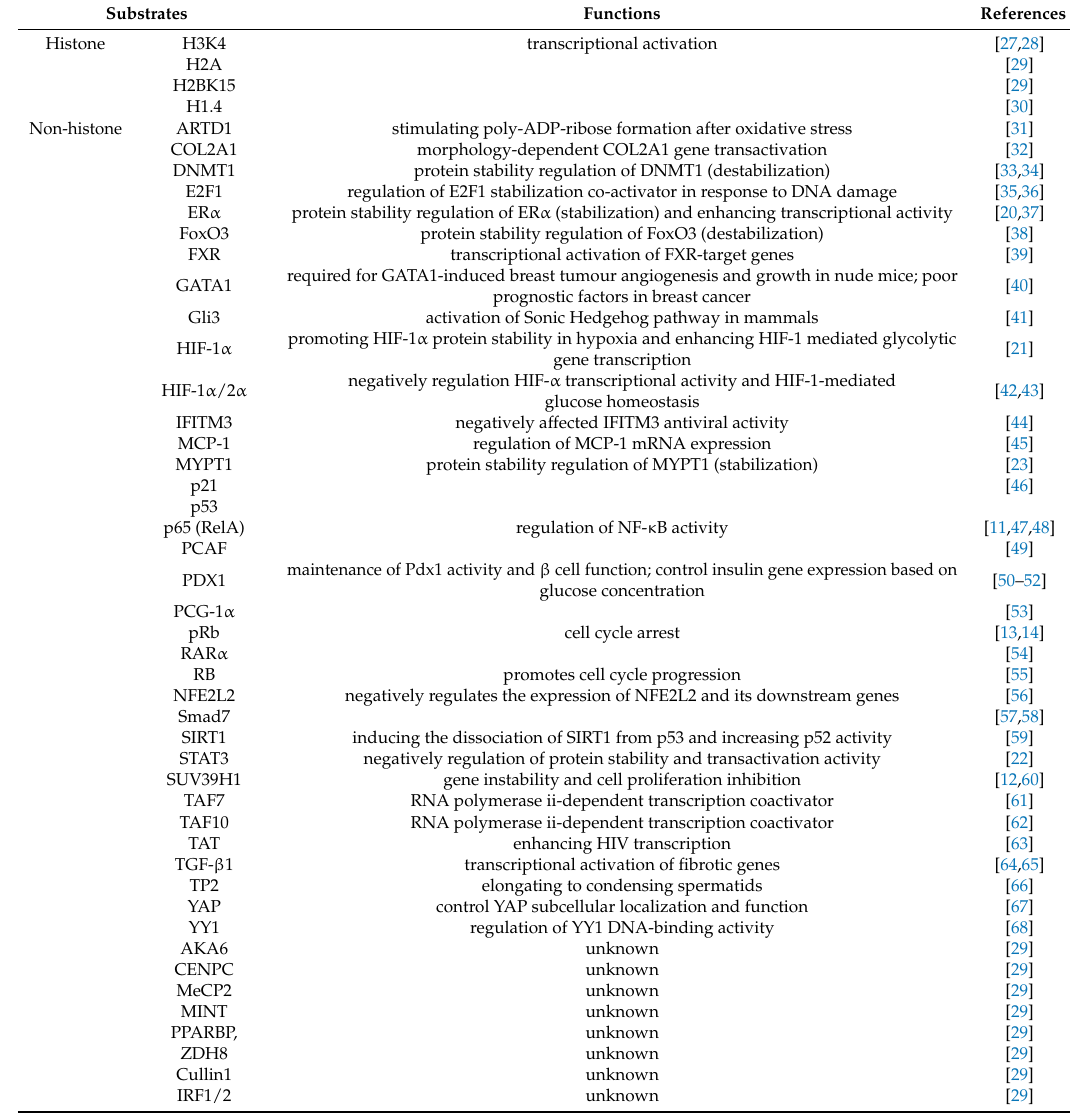
Table 1. SET7 substrates and its biological